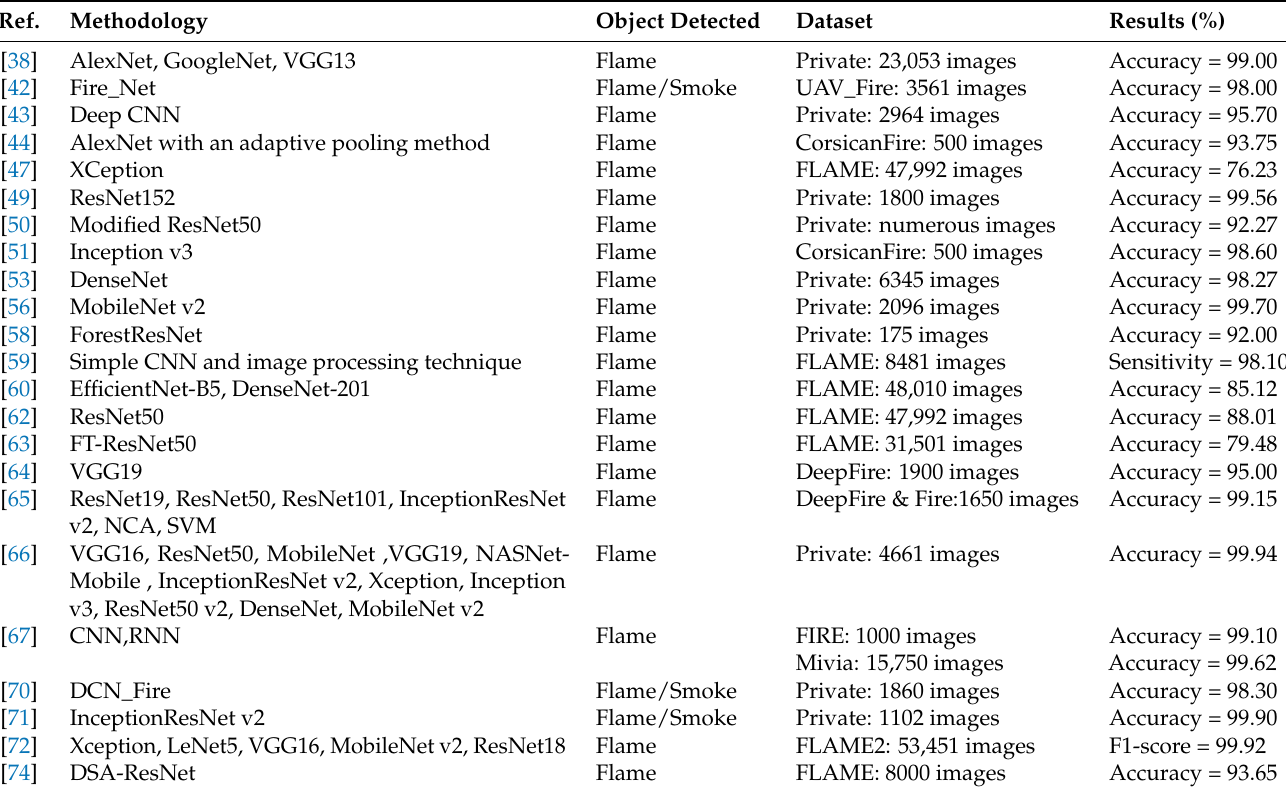
Table 1. CNN models for wildland fire classification.